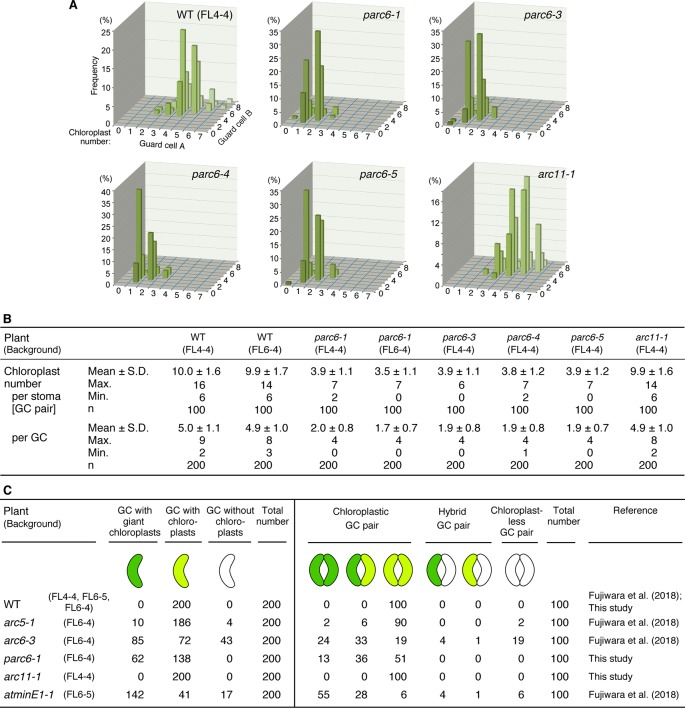
Distribution of chloroplasts in leaf stomatal guard cells of Arabidopsis parc6 and other plastid division mutants. (A, B) Measurements of chloroplast number in arbitrarily selected 100 guard cell (described as “GC” in this figure) pairs (“cell A” and “cell B”) of WT, parc6-1, parc6-3, parc6-4, parc6-5 and arc11-1 seedlings in graph (A) and table (B) form. All plants were derived from the FL4-4 line, and the 3rd and 4th leaf petioles of 4-week-old seedlings were examined. (C) Frequency of guard cells with giant, normal-sized, or no chloroplasts in parc6-1, arc11-1, and other mutant plants, based on results in the present study and previous study (Fujiwara et al., 2018). The fluorescence assays were representative of several measurements. Three to five independent leaves were used for each measurement.